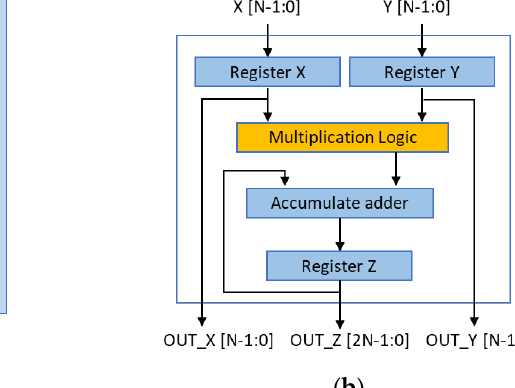
Figure 2. Previous systolic-array redundant architecture [12]: ( a ) Overview; ( b ) Repair example.